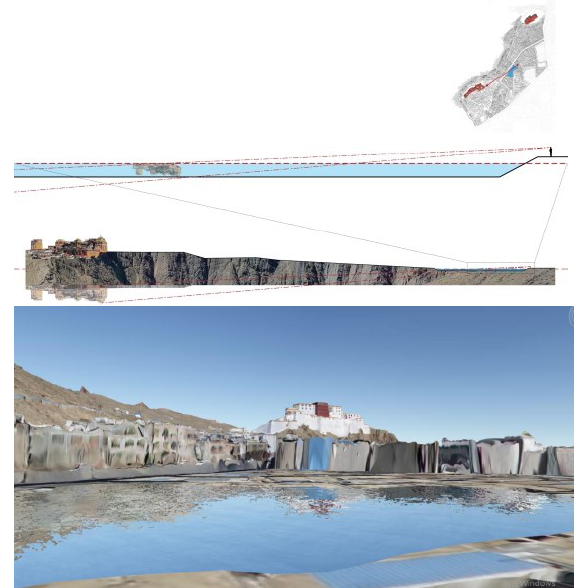
Figure 11. 3D oblique photography of current conditions overlay with simulated water body planned